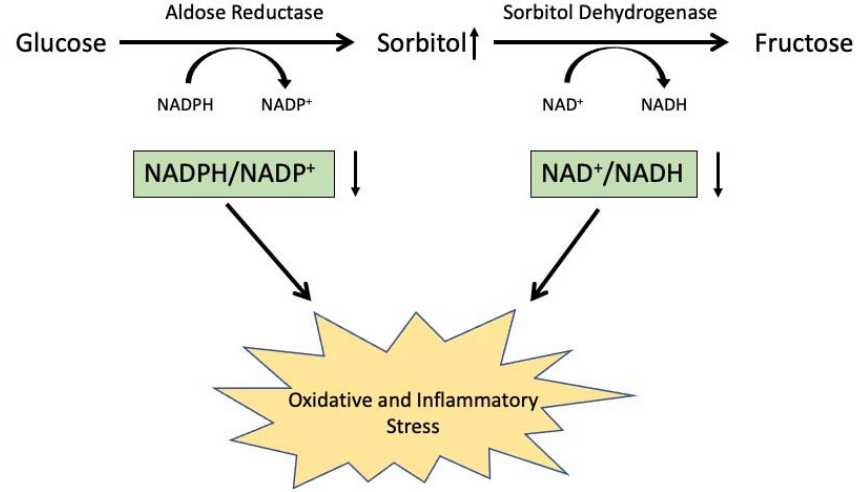
Figure 7. Consequences of increased AR leading to NAD(P)H redox imbalances and the induction of oxidative and inflammatory stress. Increased flux of glucose through the polyol pathway leads to sorbitol accumulation, redox changes in NAD(P) + /NAD(P)H ratios, and oxidative and inflammatory stress.